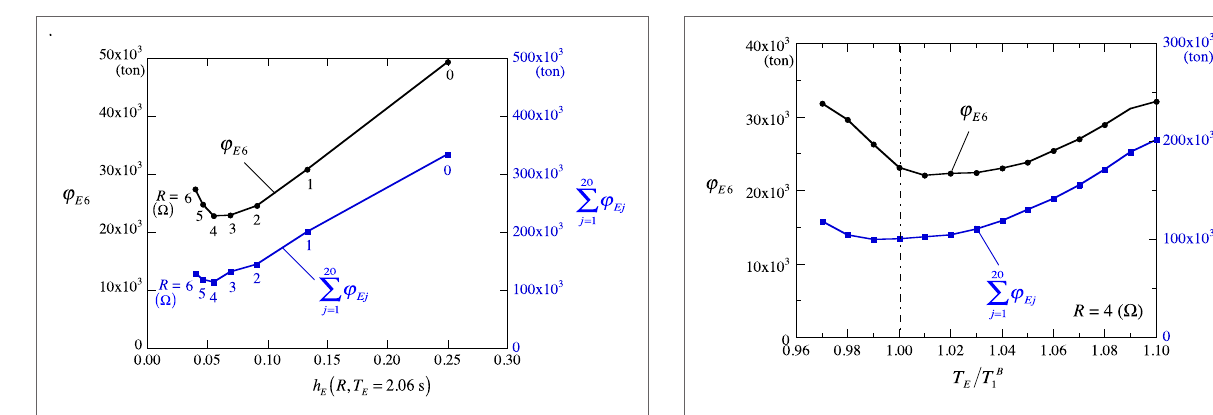
FIGURE 11 | Dependence of necessary inertial mass on the tuned electromagnetic inertial mass damper tuning period .